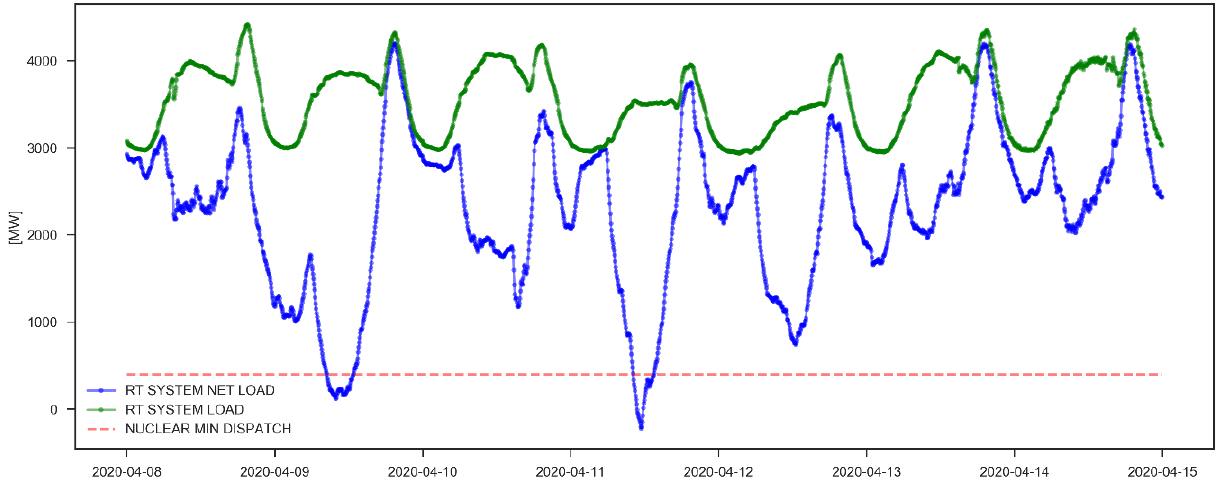
Figure 5. The load, net load, and minimum dispatch of nuclear power generation occurring in the RTS-GMLC during Duck week.